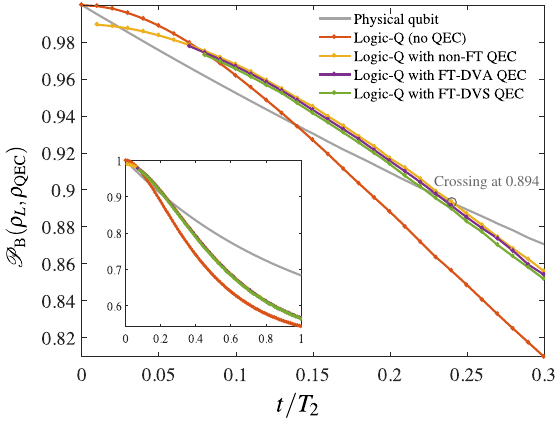
FIG. 30. Future hardware: Success probability P according to the shuttling-based, two-species protocol. The scenario simulated in this case is the same as in Fig. 29, except that the parameters applied correspond to the future improved values from Tables II – V. Performance is obviously profoundly improved, as discussed in the main text.